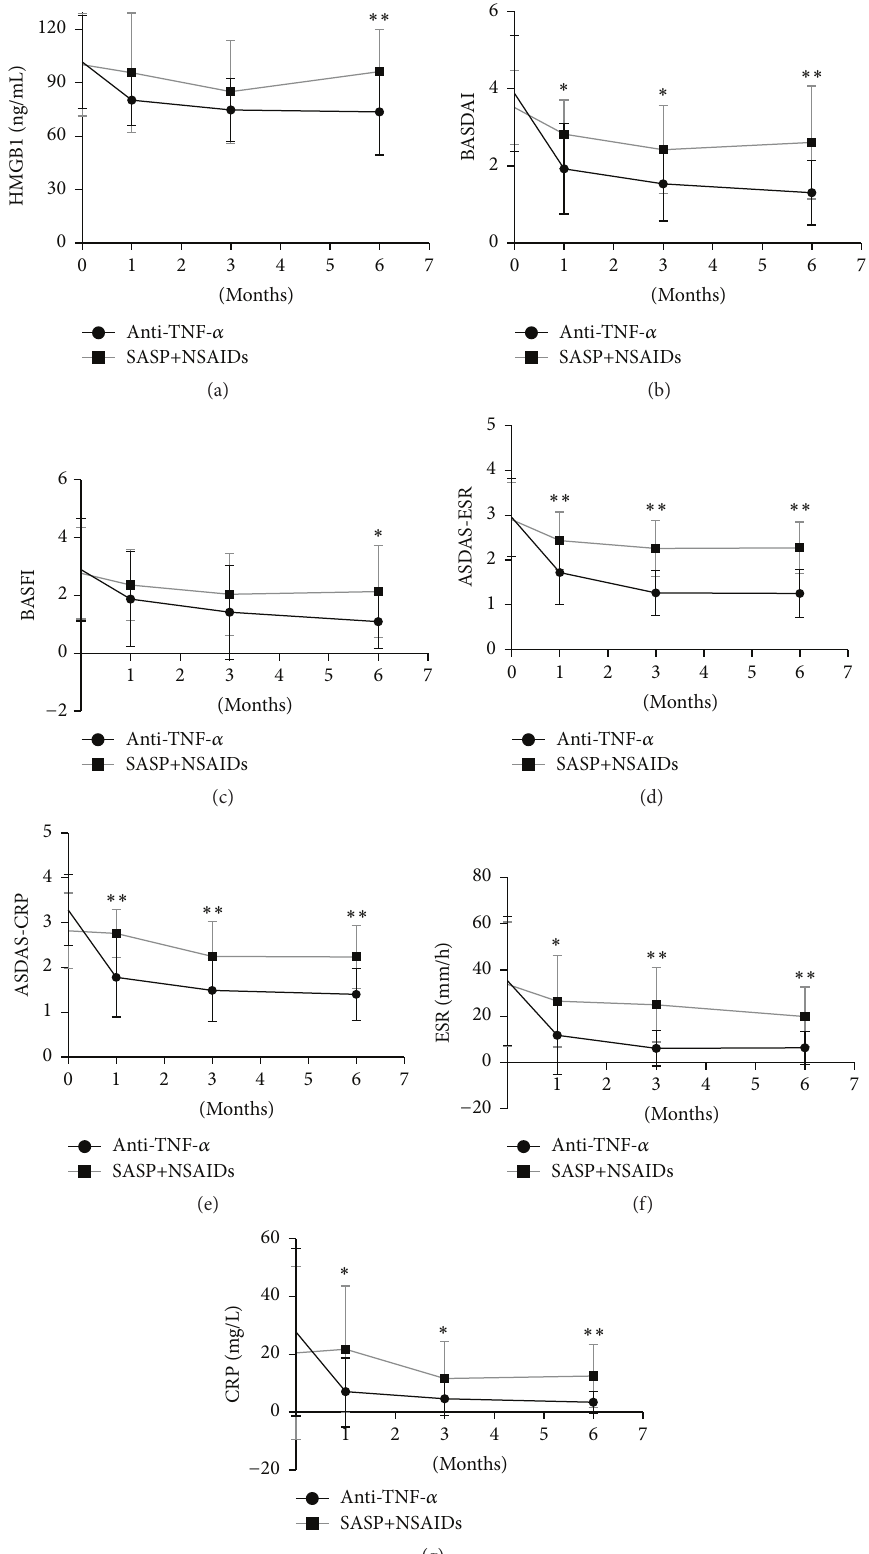
Figure 2: Changes in HMGB1 level and disease severity indices during follow-up. The black lines represent above indexes of AS patients treated with anti-TNF-a biologics and the gray lines represent patients treated with SASP and NSAIDs, during follow-up period. ∗ indicates 𝑃 < 0.05 ; ∗∗ indicates 𝑃 < 0.01